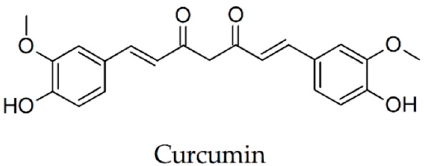
Figure 6. Chemical structure of curcumin.